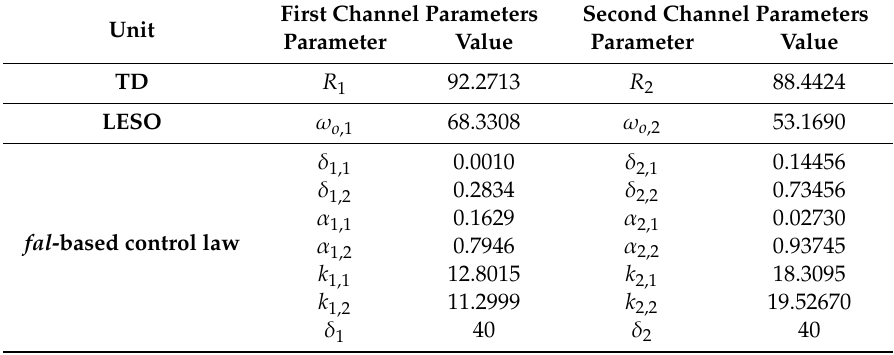
Table 1. The parameters of the first configuration (conventional ADRC (CADRC))